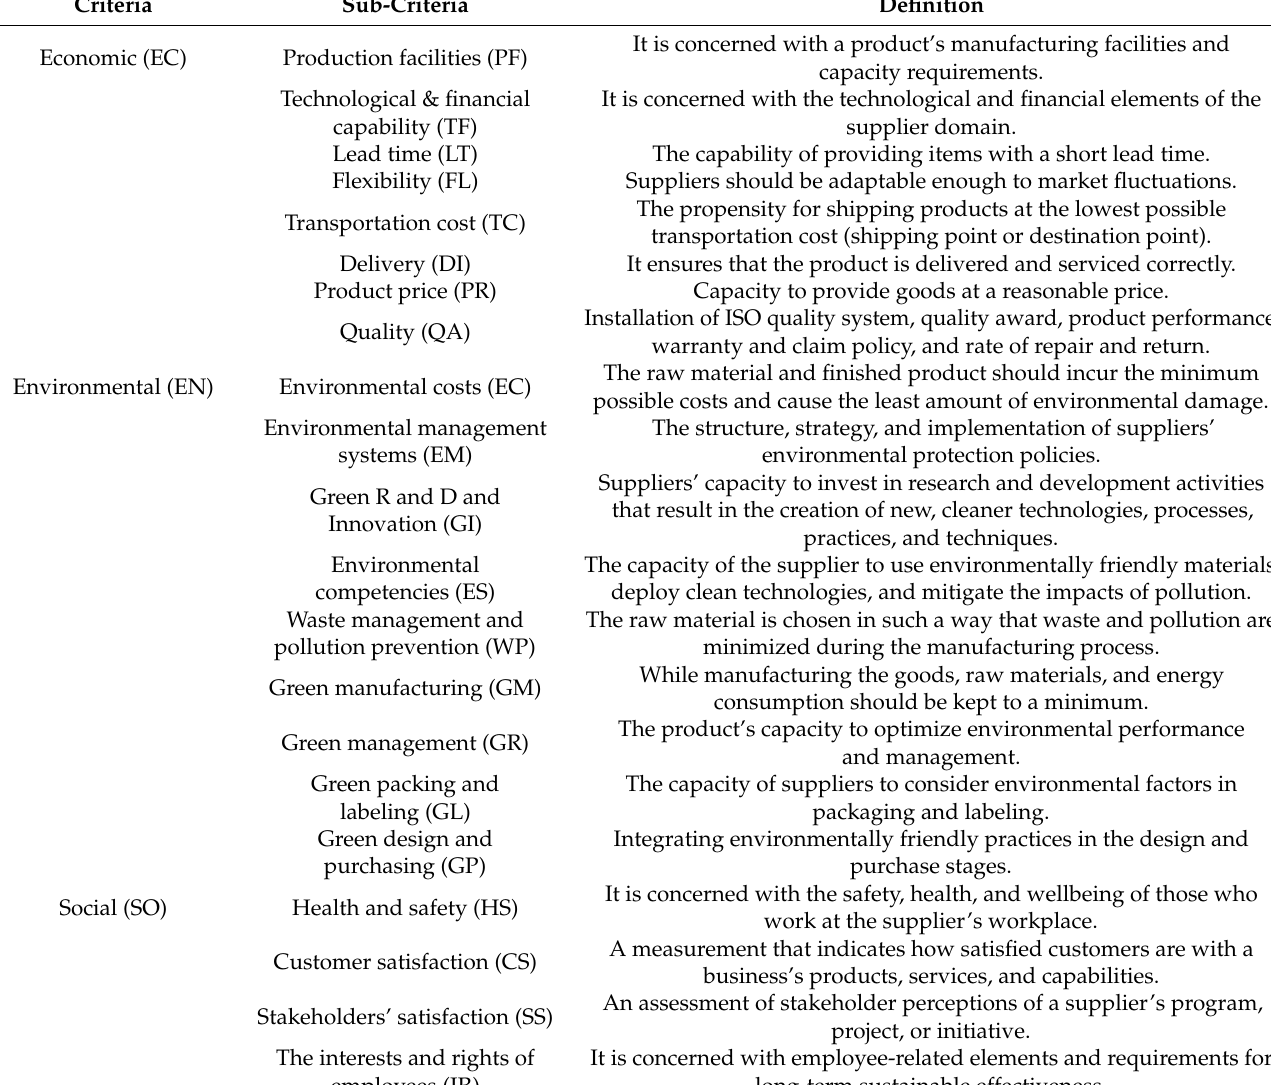
Table 6. Descriptions of criteria and